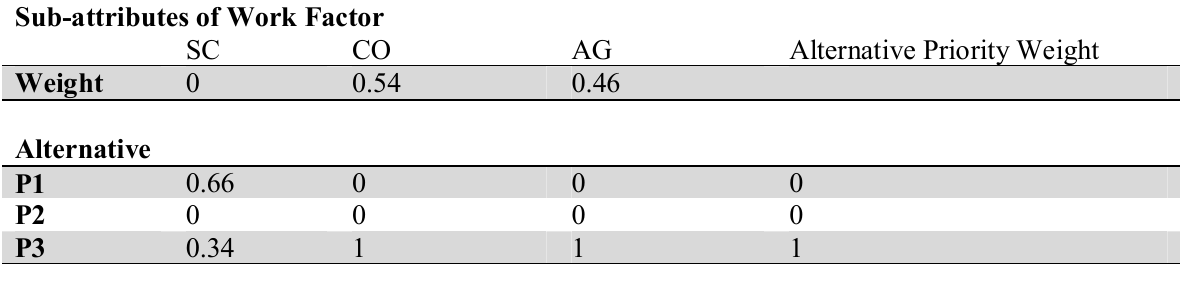
Summary combination of priority